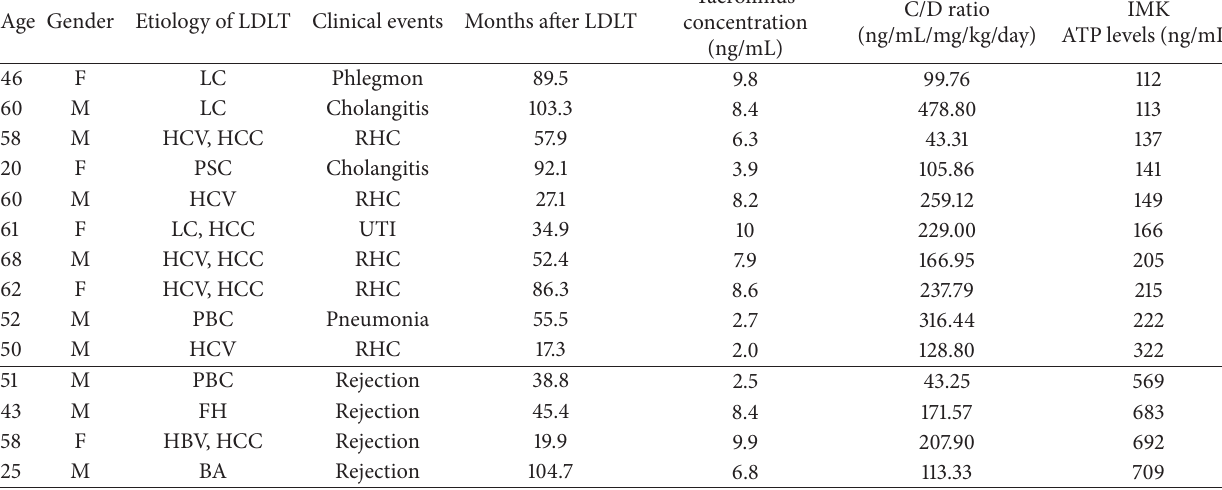
Table 2: IMK ATP levels in the patients who experienced late clinical